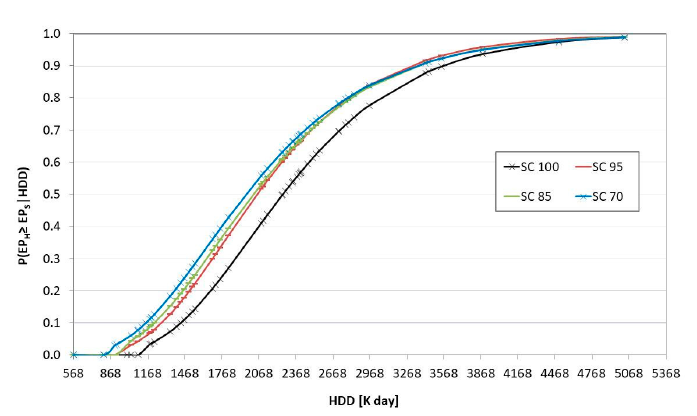
Figure 11. Energetic fragility curves—2-storey building.